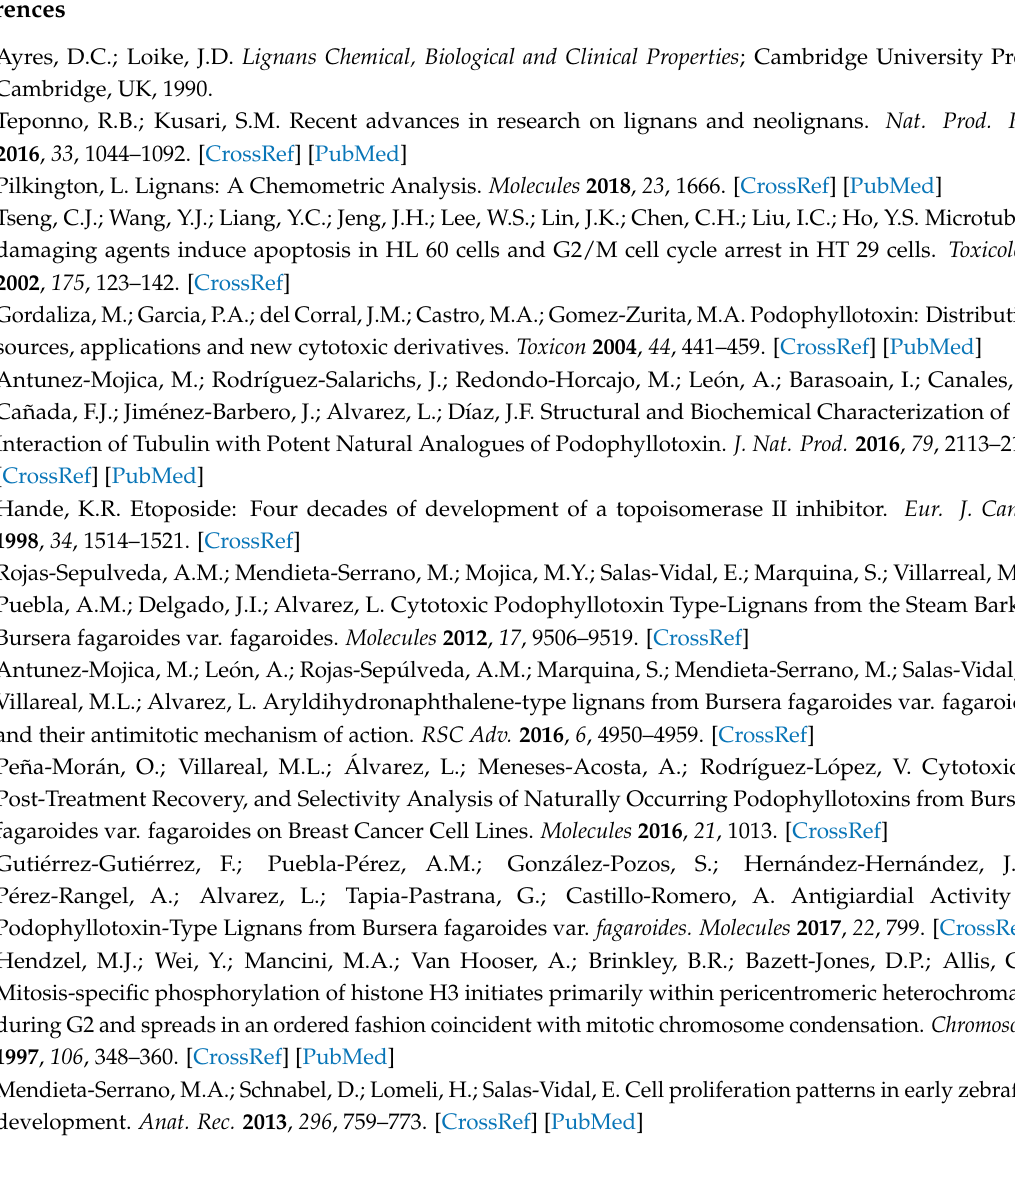
embryos. Table quantification of H3S10ph by the extract and fractions. 1 H NMR table of pure compounds ( 1 – 7